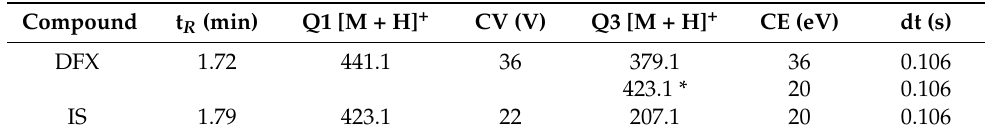
Table 1. Optimized UPLC-MS/MS parameters for DFX and